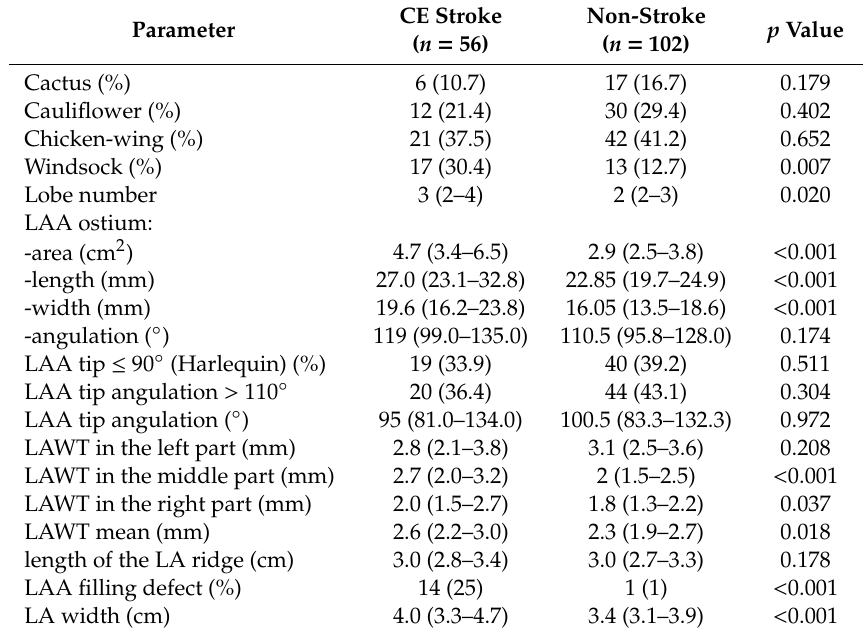
Table 2. LAA and LA morphology in patients with cardio-embolic (CE) stroke compared to patients without